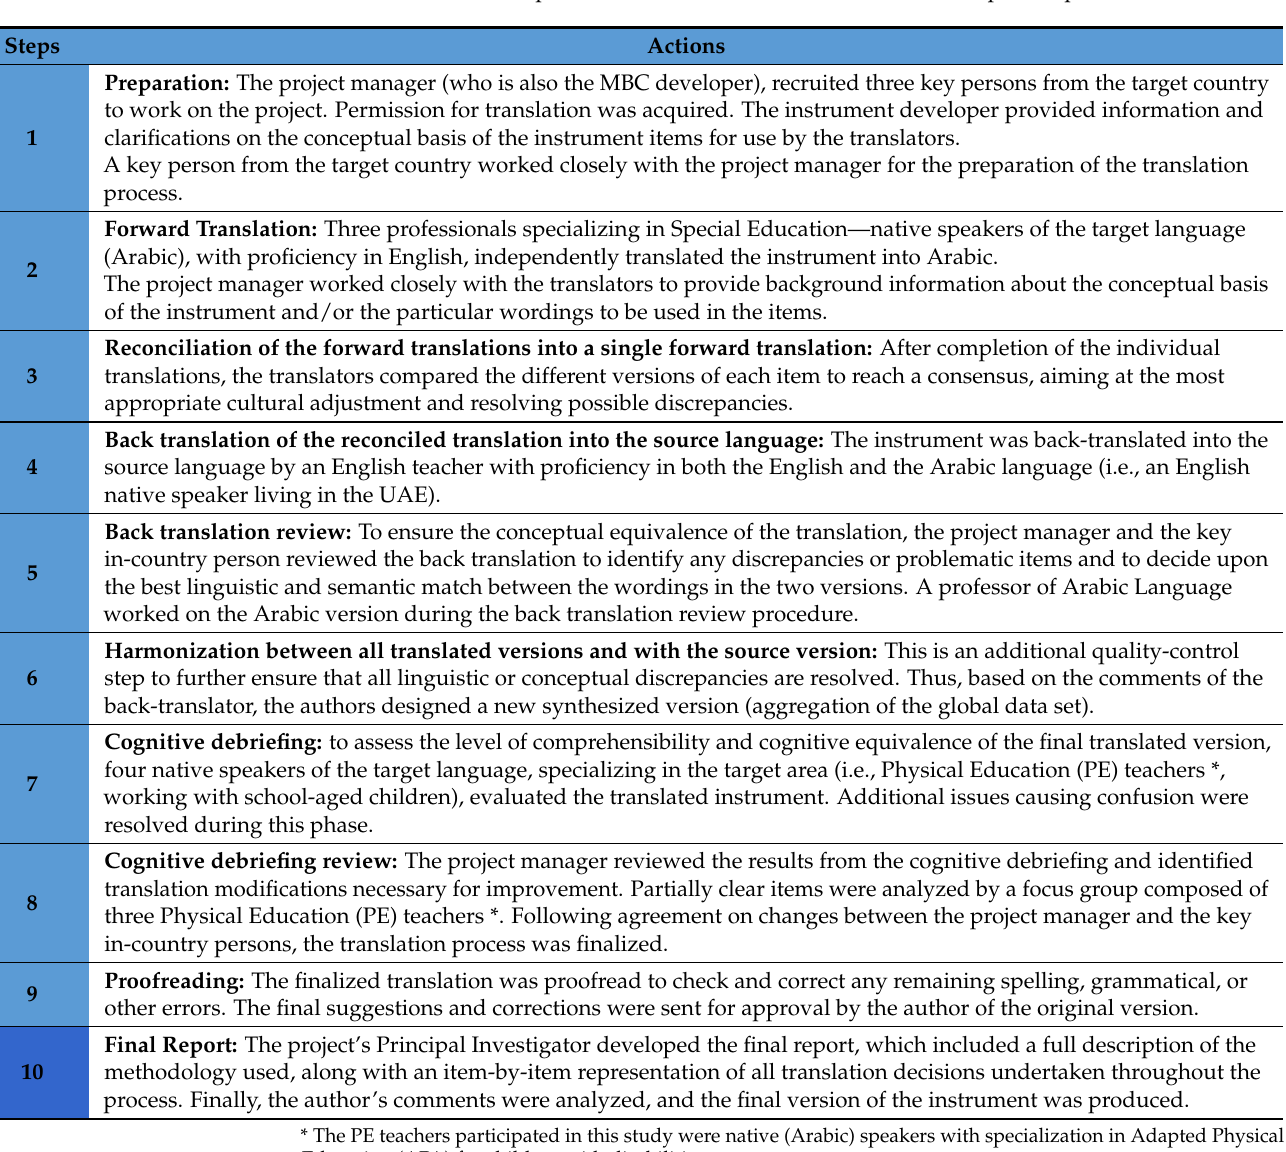
Table 1. Detailed description of the translation and cross-cultural adaptation process of the